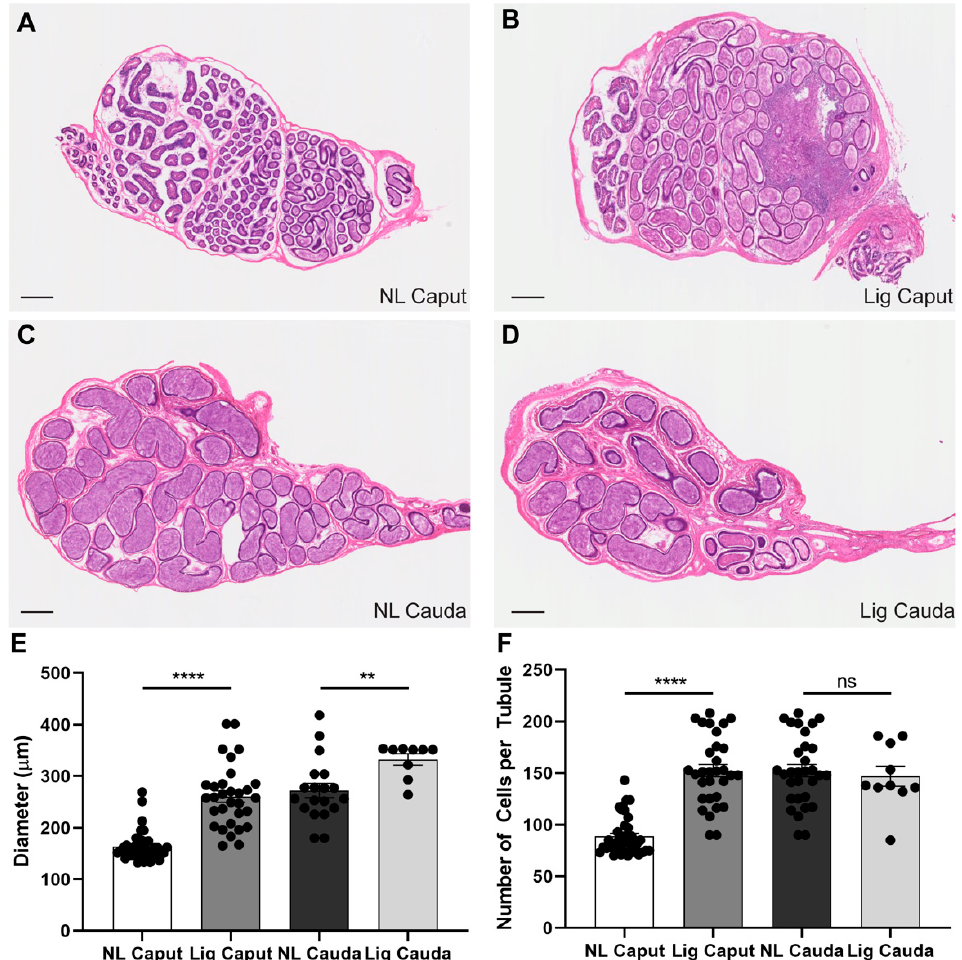
Figure 2. Effects of ligation on epididymal tissues. H&E histological staining comparison of the four epididymal experimental regions at 7-days post ligation surgery. ( A – D ) Sections of non-ligated caput (NL Caput), ligated caput (Lig Caput), non-ligated cauda (NL Cauda) and ligated cauda (Lig Cauda) regions. Scale bar = 200 µ m. n = 3. ( E ) Quantification of tubule diameter comparison between the four experimental regions. Independent experiments n = 3; NL and Lig Caput tubules n = 40, NL and Lig Cauda tubules n = 10. ( F ) Quantification of Hoechst-positively stained cells comparing the number of cells per round tubule. Independent experiments n = 3; NL and Lig Caput tubules n = 40, NL and Lig Cauda tubules n = 10. Statistical significance comparing NL Caput vs. Lig Caput and NL Cauda vs. Lig Cauda using an unpaired t -test in all graphs indicated; ns p > 0.05, ** p < 0.01, **** p <